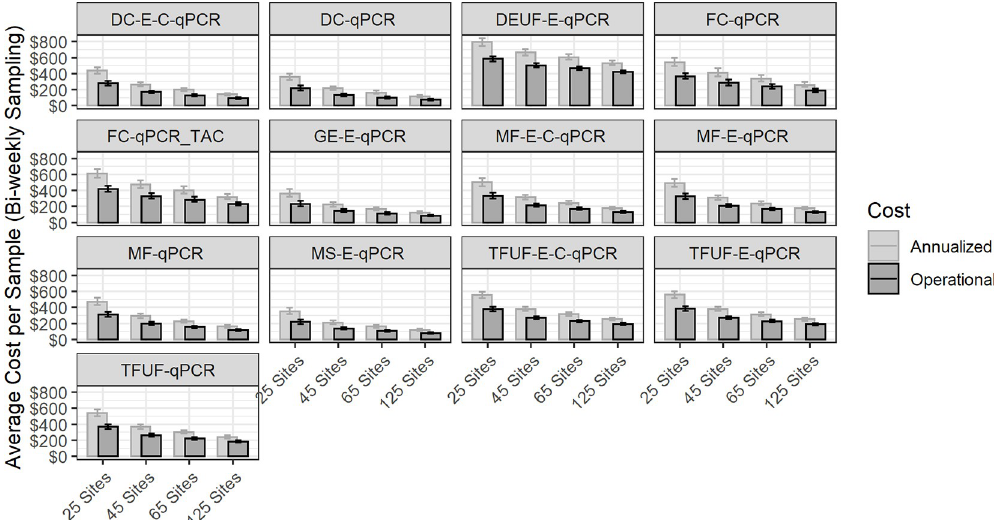
Fig 2. Total annualized cost (inclusive of all costs, including overhead, buildings, and management) and operational costs (running costs only) for an example number of twenty-five, forty-five, sixty-five, and a hundred and twenty-five sites, sampled bi-weekly. All values in 2019 US dollars. Error bars represent the 25 th and 75 th percentile of simulated results. DC, differential centrifugation; DEUF, dead end ultrafiltration; FC, filter cartridge; GE; grab enrichment; MF, membrane filtration; MS, Moore swab; TFUF; tangential flow